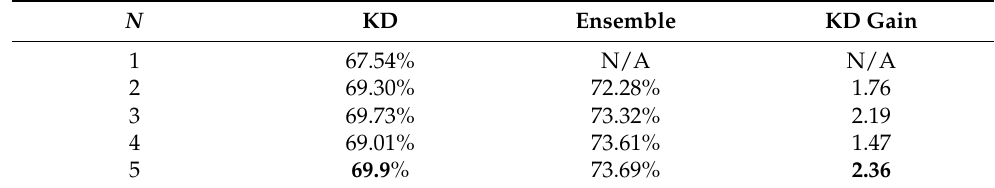
Table 7. The effect of the number of students N on the distillation performance.(best results repre- sented in